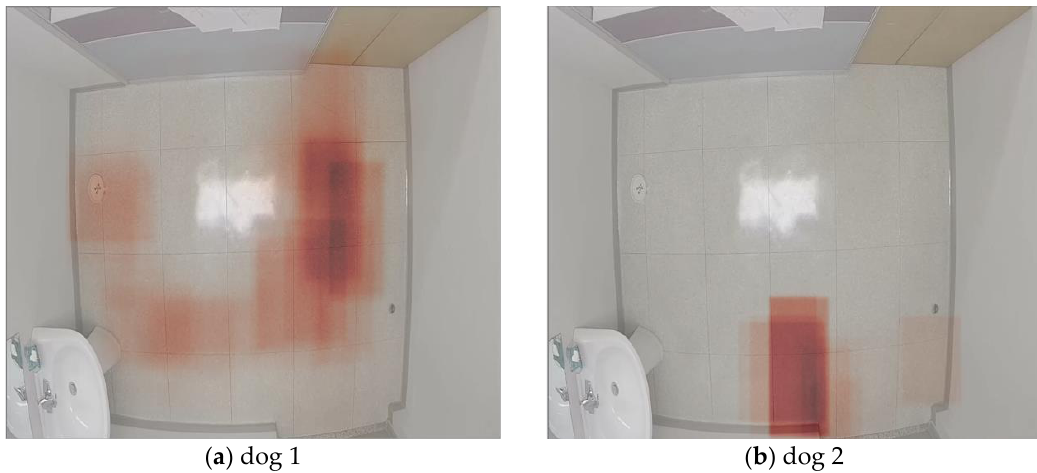
Figure 8. Heatmap visualization of areas where the dog spends longer time: ( a ) example of scenario with dog 1; ( b ) example of scenario with dog 2.